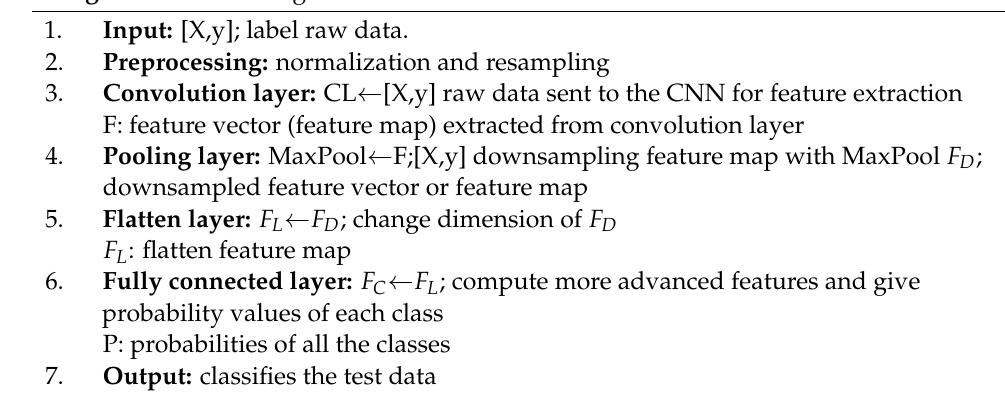
Algorithm 1 CNN algorithm for PV fault